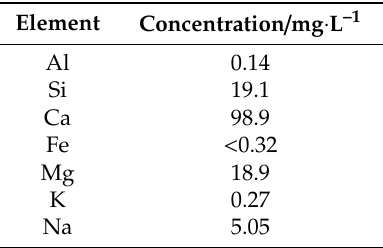
Table 5. Concentration of elements leaching from FA particles into AR × 10, during 24 h stirring of the suspension. The alkaline elements were analyzed by Atomic Absorption Spectroscopy (AAS), while the other elements were quantified by Inductively Coupled Plasma-Optical Emission Spectroscopy (ICP-OES).